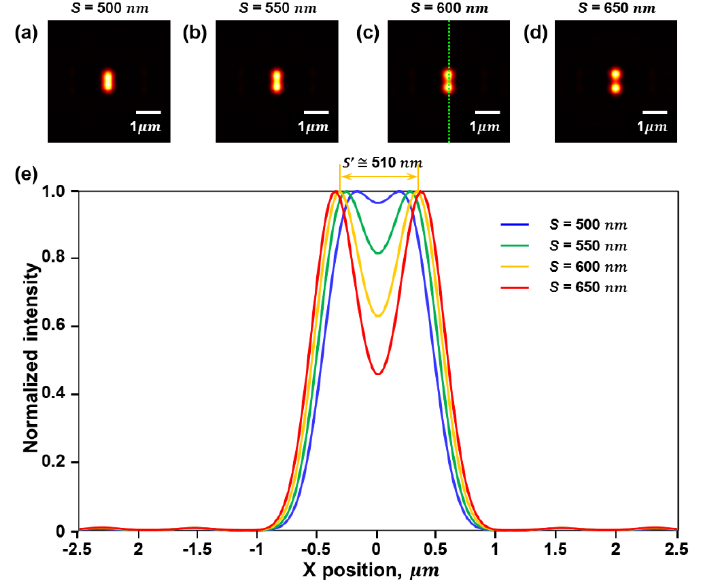
Figure 4. Imaging of two separated incoherent point light sources by a radially (20-fold) symmetric quasi-periodic nanohole array lens. Plates ( a ) to ( d ) show the calculated patterns of imaging two incoherent light sources with the separation of 500 nm, 550 nm, 600 nm, and 650 nm, respectively. Plate ( e ) shows the cross-section profiles of the two imaged spots in the imaged patterns. Note that two incoherent point light sources are resolved when they are separated by S = 600 nm, while a distance between the two imaged spots is around S ′ = 510 nm, giving an effective N.A. of